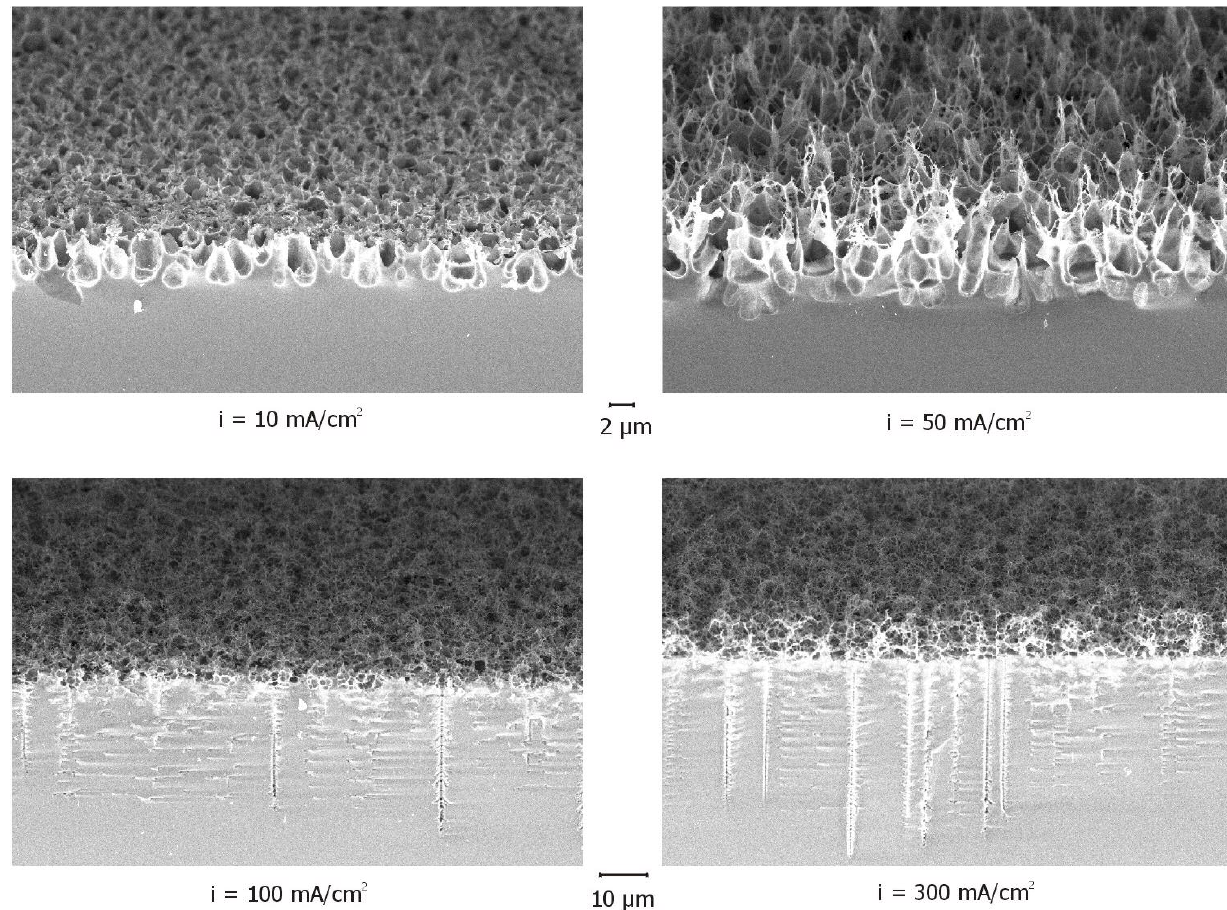
Figure 2. SEM cross section of macroporous silicon samples, etched with current densities between 10 mA/cm 2 and 300 mA/cm 2 . When using low current densities (10 mA/cm 2 - 50 mA/cm 2 ), a homogenous distribution of the pore depth (5 µm-8 µm) can be observed. Utilising high current densities (100 mA/cm 2 -300 mA/cm 2 ) effects the formation of crater- like